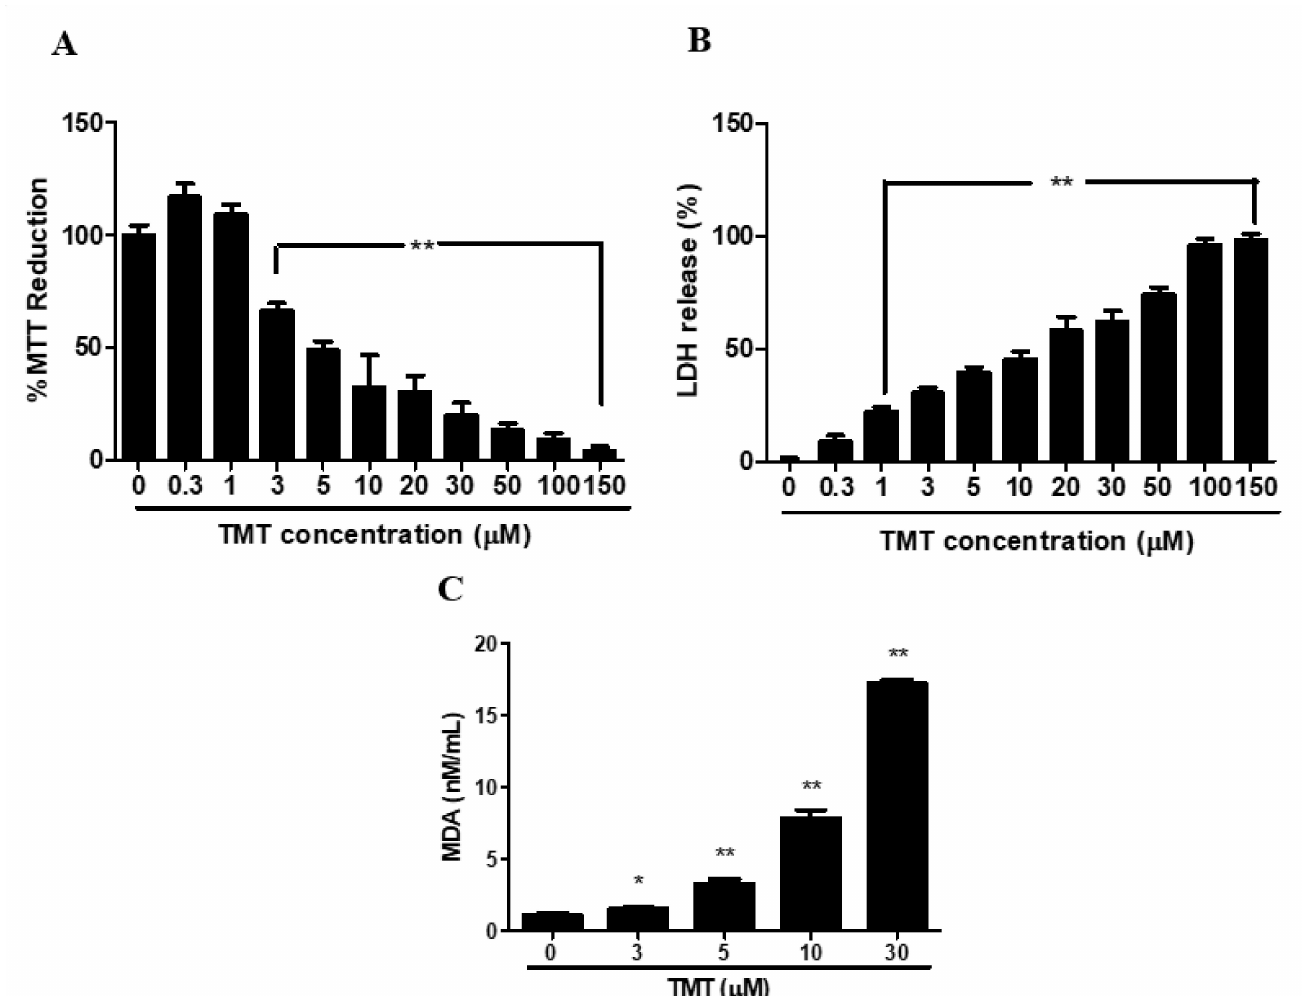
Figure 1. Dose-toxicity effects of trimethyltin (TMT) in human dopaminergic neuroblastoma SH-SY5Y cells. Cell viability and lipid peroxidation induced by TMT were measured by MTT reduction ( A ), lactate dehydrogenase (LDH) ( B ), and malondialdehyde (MDA) assays ( C ). * p < 0.05, ** p < 0.01 compared to control group ( n = 4). Experiments were performed at least three times, with similar results. n: number of wells in each